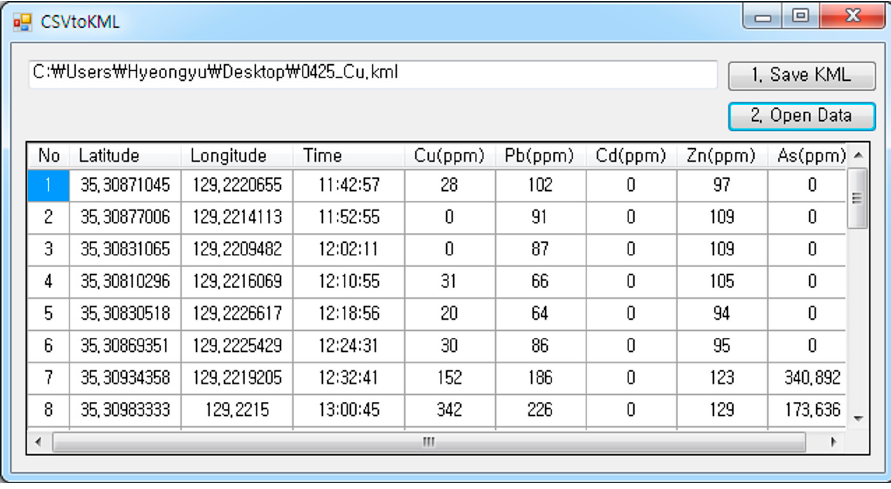
Figure 5. Interface of the comma-separated value (CSV) to Keyhole Markup Language (KML) program developed in this study.